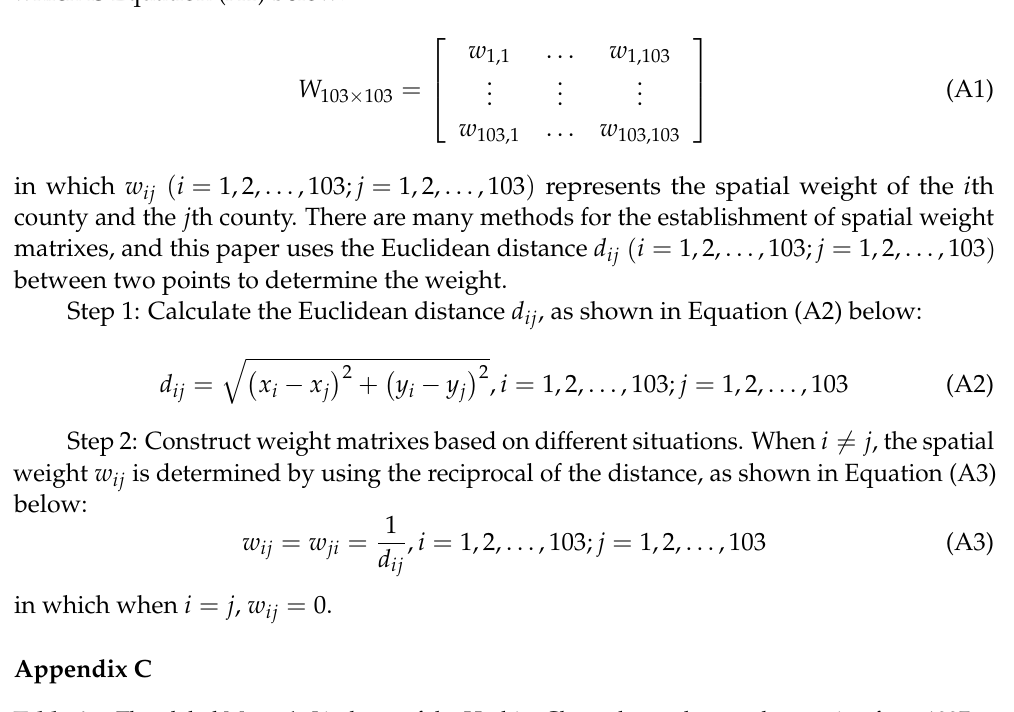
Table A1. The global Moran’s I indexes of the Harbin–Changchun urban agglomeration from 1997 to